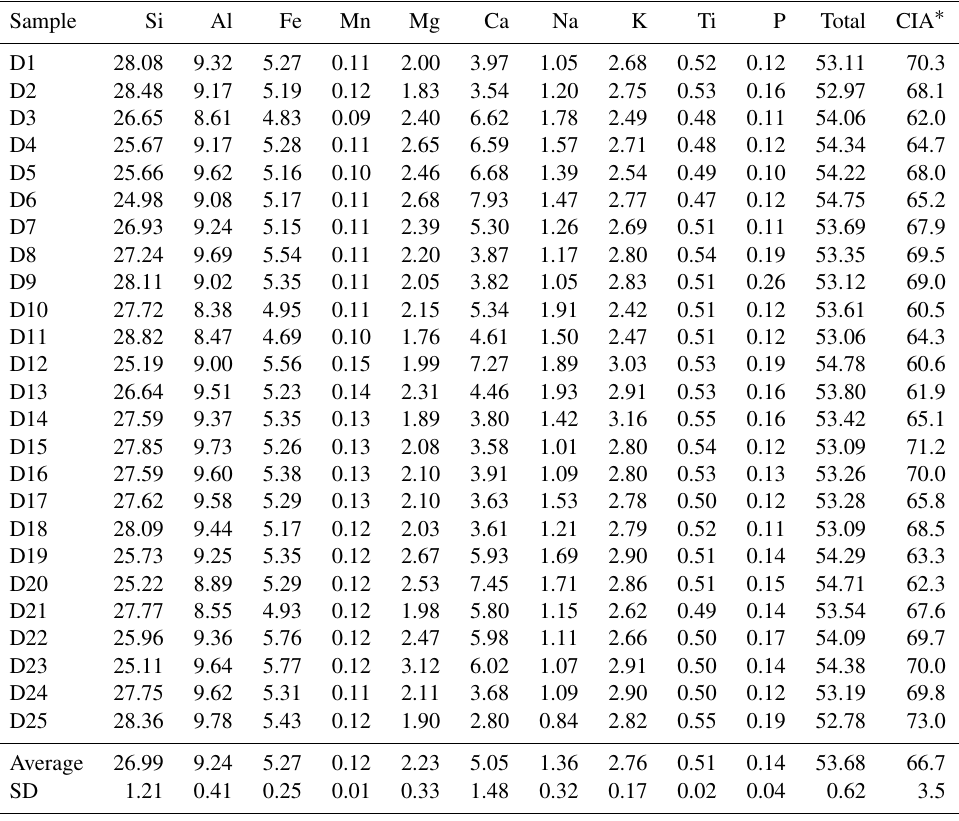
Table 3. Major element composition of Asian dust (in wt%) on a volatile-free basis.